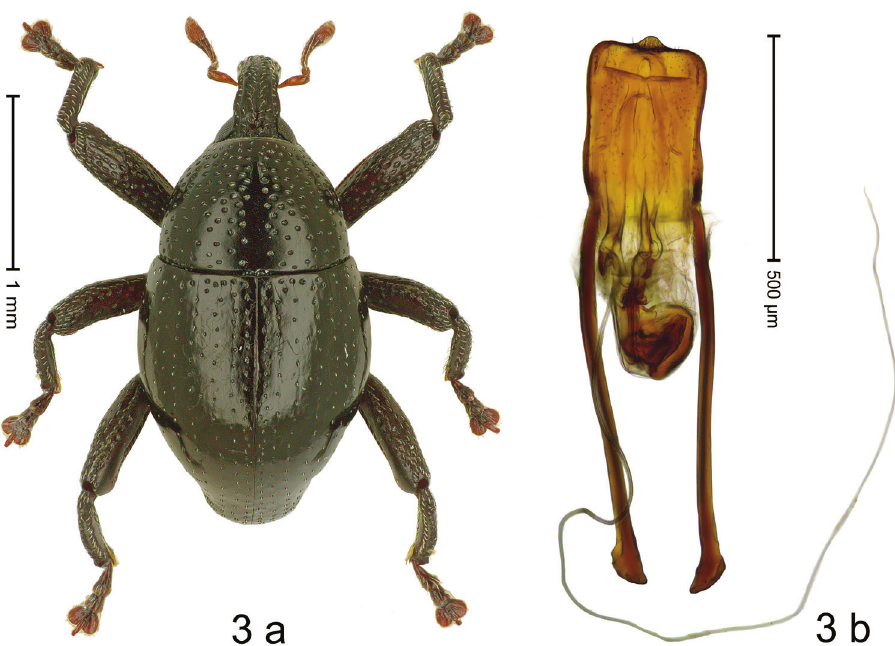
Figure 3. Trigonopterus arcanus sp. nov., holotype a habitus b